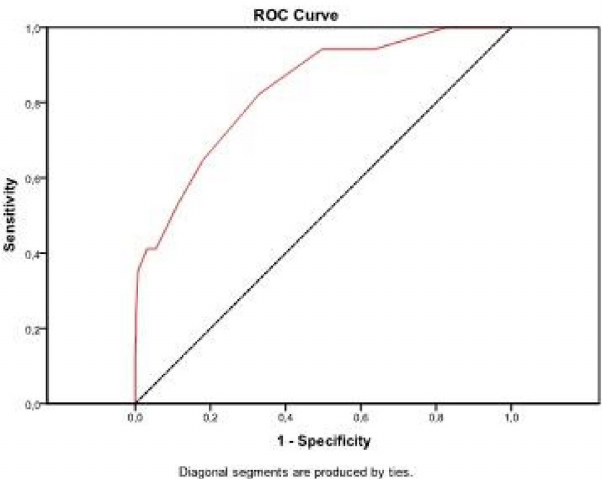
Fig. 3 – Graph of the ROC curve for RTI